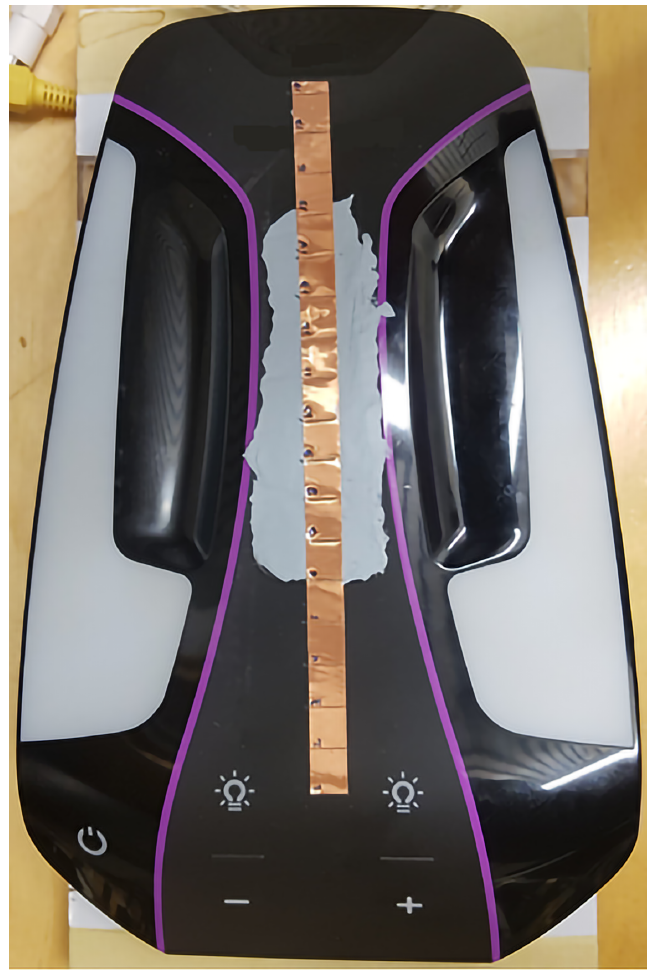
Figure 7. The control panel top view. The central slider is filled in with Blu Tack for Measurements to be completed using the MicroSense